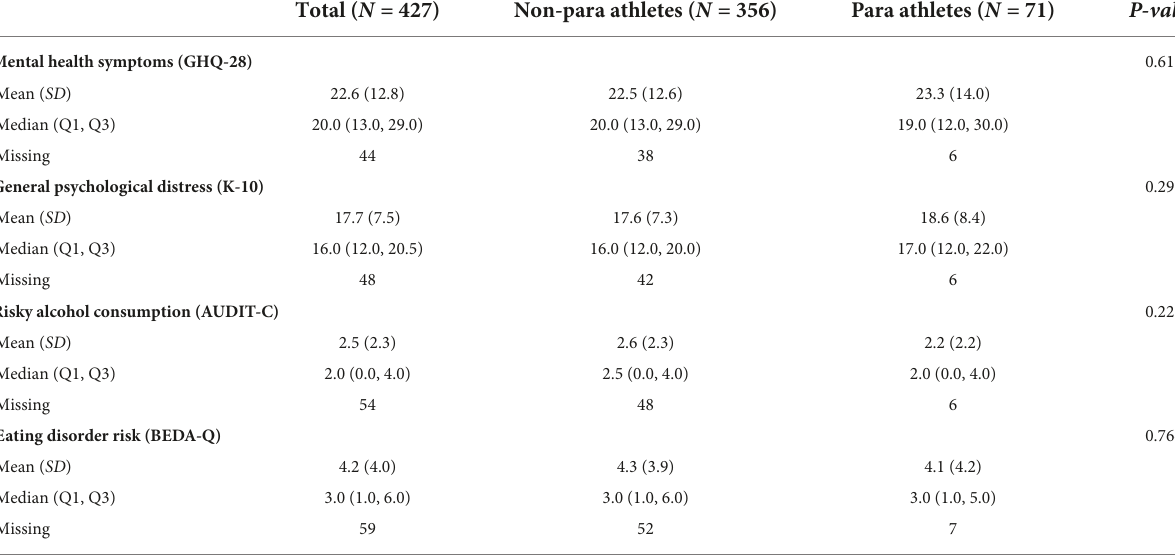
TABLE 2 Mental health symptoms among currently competing elite non-para athletes and para